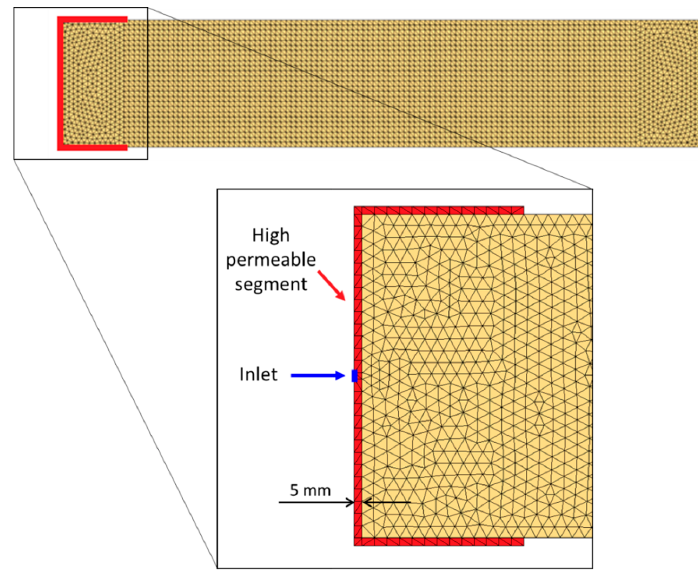
Figure 4. Design of C-shaped inlet used for simulating case A in Figure 3.